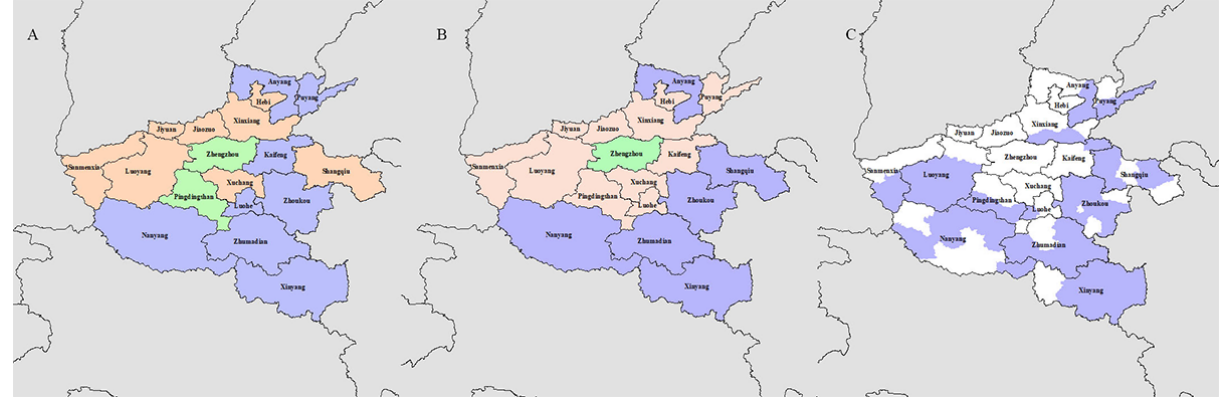
Figure 3. Classification of pulmonary tuberculosis (PTB) epidemiological regions through cluster analysis in Henan province, China, from 2005 to 2018. A: Classification of all PTB epidemiological regions. B: Classification of bacteriological-positive PTB epidemiological regions. C: Distribution of poverty-stricken